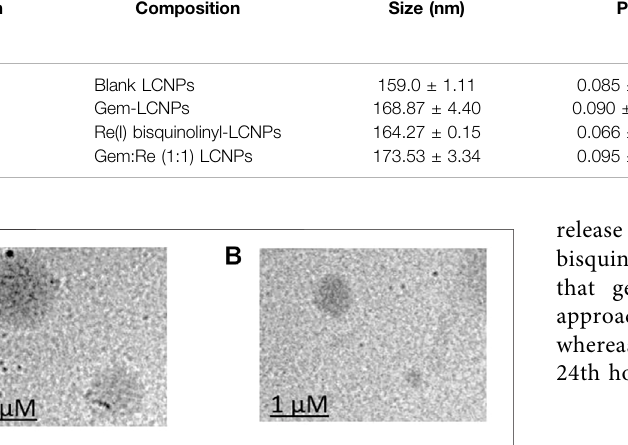
Frontiers in Pharmacology |